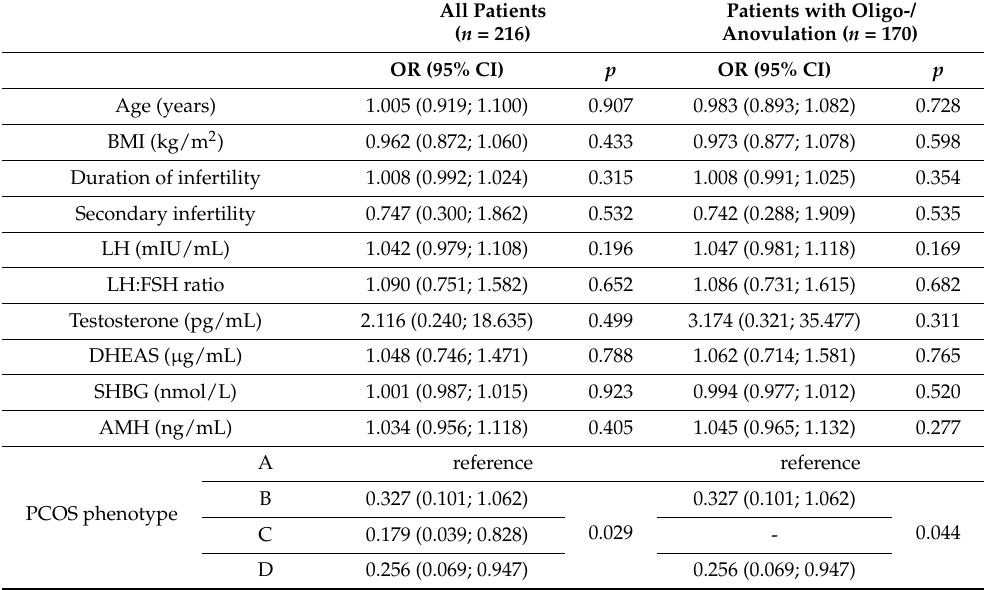
Table 3. Basic patient characteristics and serological parameters relative to Fallopian tubal occlusion: results of univariate logistic regression analyses.